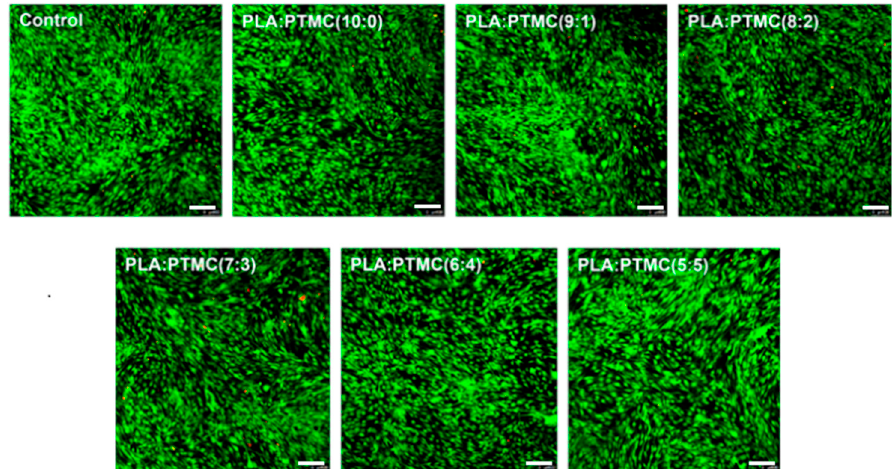
Figure 8. Photos taken with a laser confocal microscope of cells cultured on PLLA/PTMC fibre membrane scaffolds characterised by different blending ratios. (scale bar: 200 μ m).